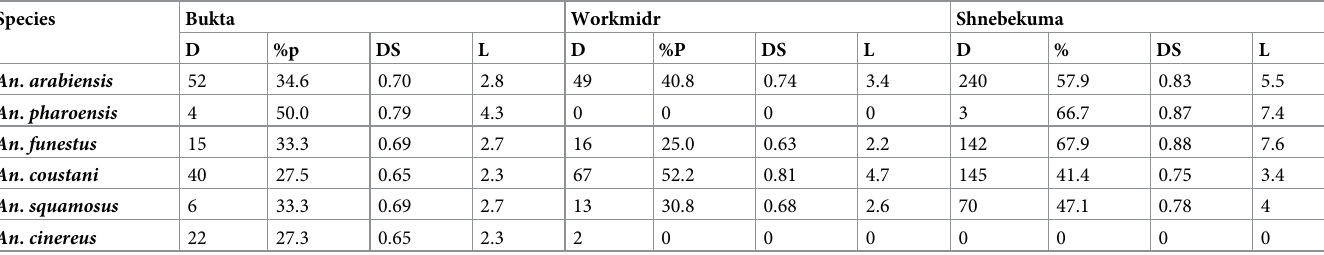
Table 2. Parous rates and longevity of Anopheles mosquitoes by villages caught by LTCs in Bure district, Ethiopia. Species Bukta Workmidr